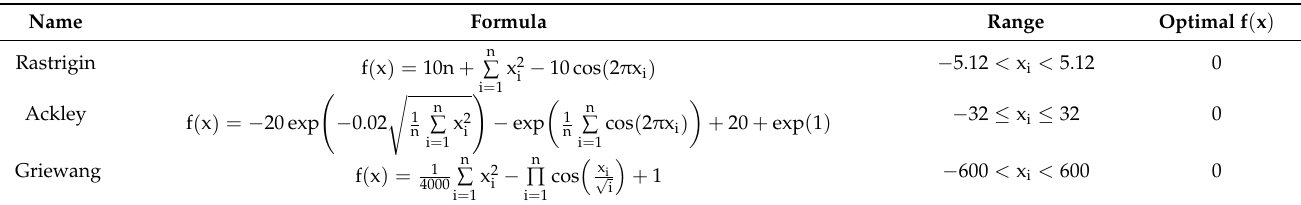
Table 2. Description of Three Benchmark Functions.